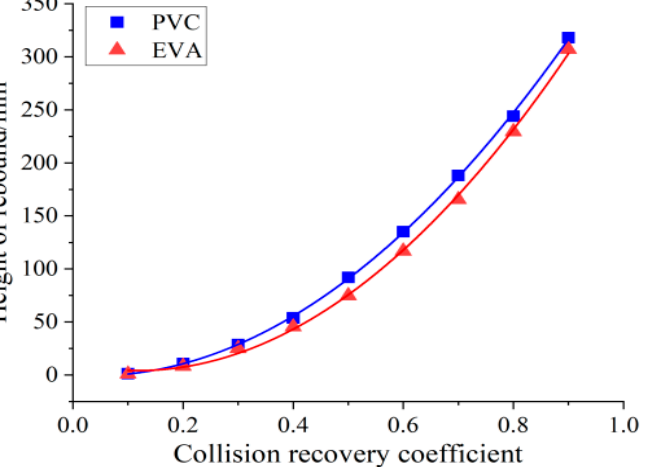
Figure 10. Fitting curve of the collision recovery coefficient and the maximum rebound height. Thus, by the method of origin, the fitting equations were shown as follows: